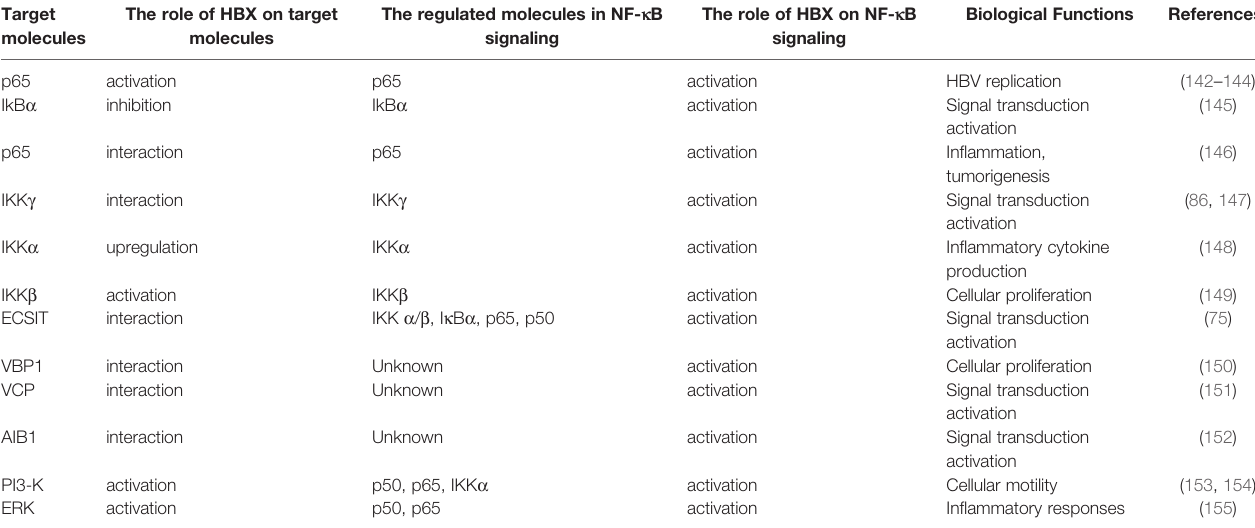
TABLE 2 | The detailed information related to the modulation of NF- k B signaling mediated by HBX. Target